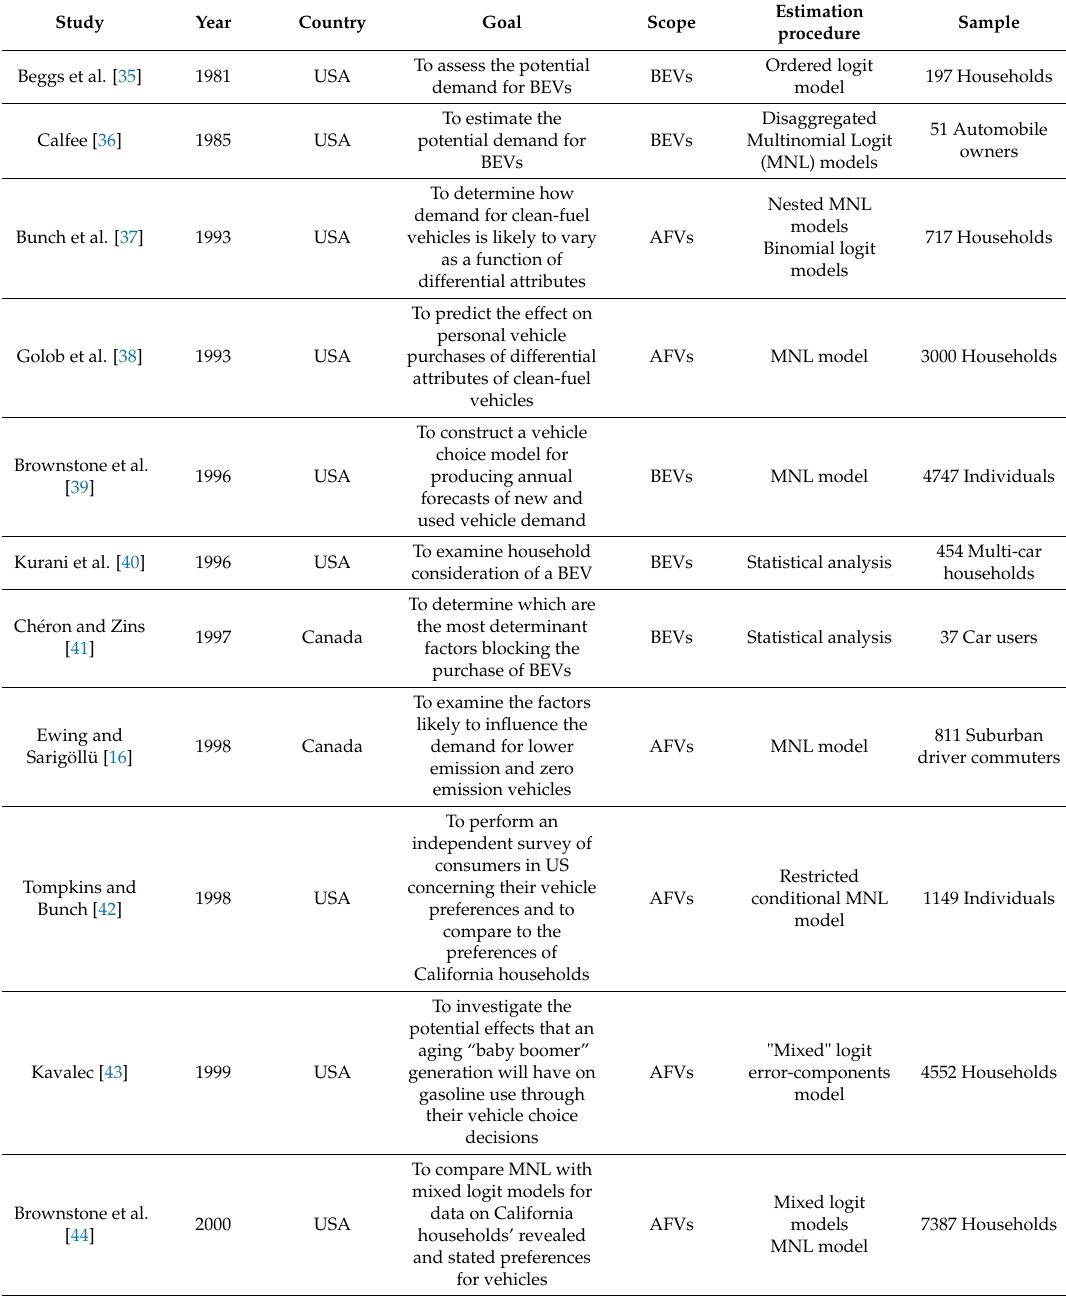
Table 1. Consumer preference studies for Alternative Fuel Vehicles